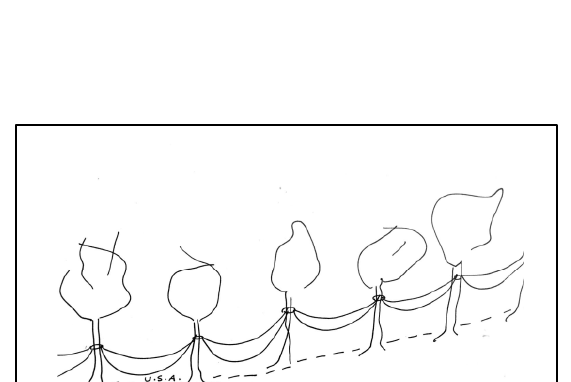
J. M. Design Studio, “Prototype #1 A Wall of Hammocks” from The Other Border Wall Proposals (2017). Digital scanned image of ink drawing on paper, text. 8 ½ X 11 inches. Collection of